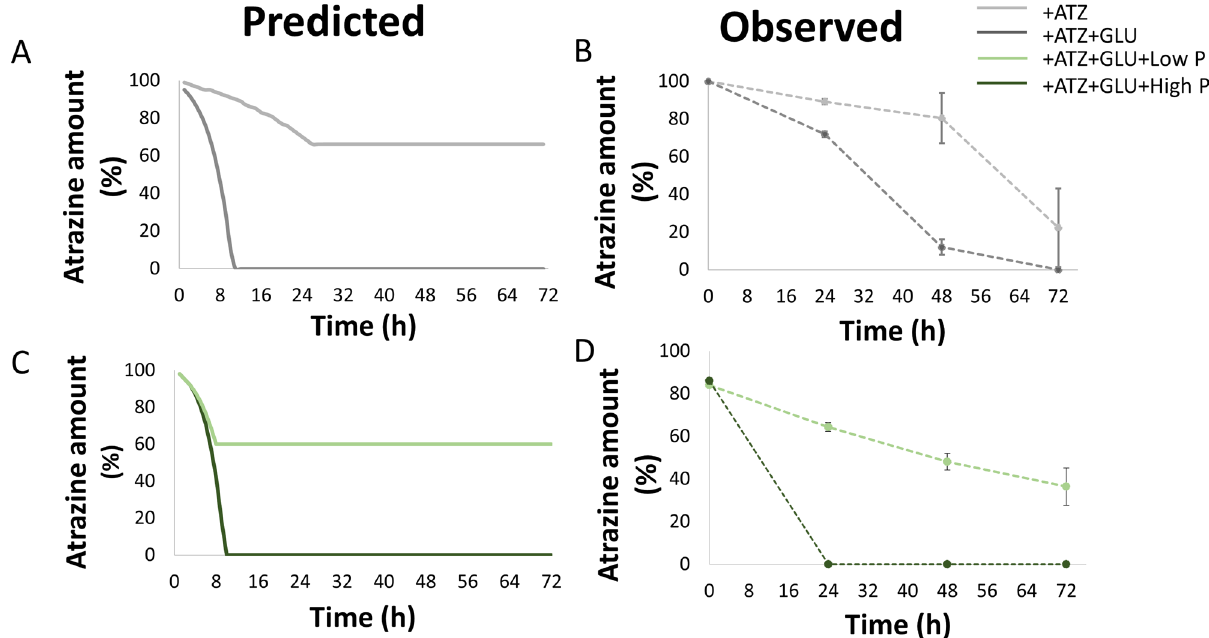
Figure 4. Predicted ( A , B ) and observed ( C , D ) atrazine degradation in modified media. High and low phosphate concentrations: 50 and 15 mmol/gdw h for predicted values and 0.081 and 0.0081 g/l for observed values, respectively. Initial atrazine amount: 30 mmol (predicted) and 30 mg/l (observed). ATZ atrazine, GLU glucose. Observed values represents mean in triplicates; bars represent